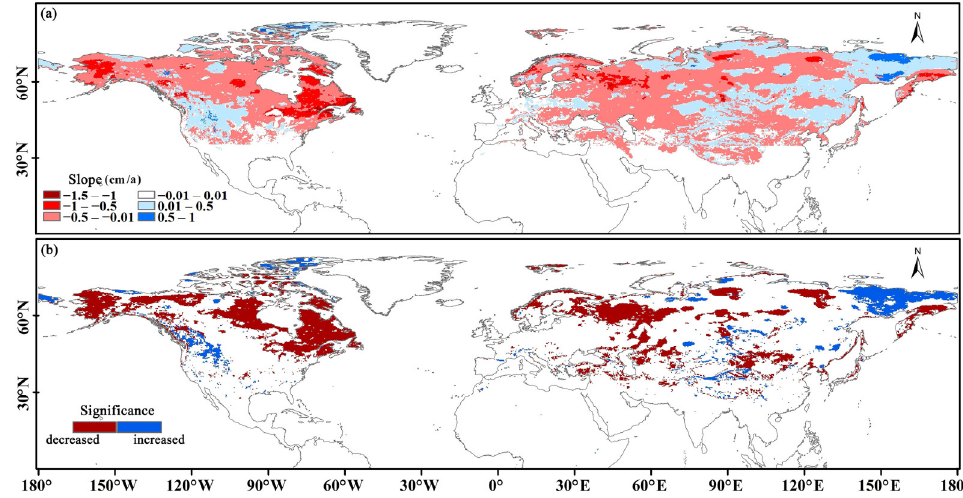
Figure 2. ( a ) Variation slopes and ( b ) significance pattern ( p < 0.05) of SD in the NH. The results of the analysis of interannual variations in monthly average SD from 1988 Among high altitudes, the SD decreased in the northern Rocky Mountains and in- to 2018 are illustrated in Figures 3 and 4. From November to March, the SD declined creased in the central and southern Rocky Mountains from October to February. The SD to −0.01 cm/a, with higher rates ranging from −2.5 cm/a to −1.5 cm/a (significant declines) 0.01 cm/a to 0.5 cm/a), while opposite trends were observed throughout the area in May, with small decreasing rates. The SD in the Qinghai–Tibet Plateau was spatially heteroge-